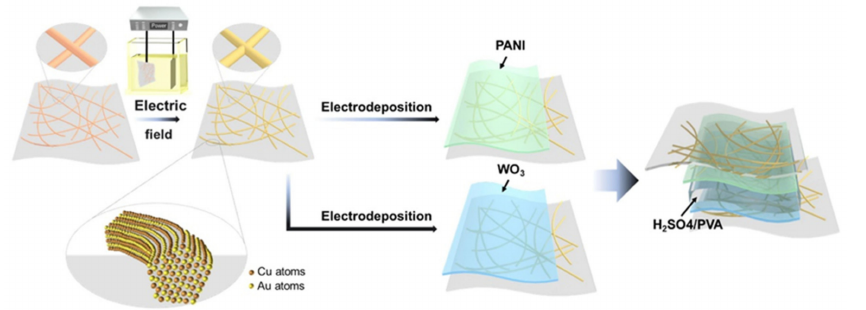
Figure 9. Schematic illustration of the fabrication process of an AEES device based on the Cu–Au NW FTEs